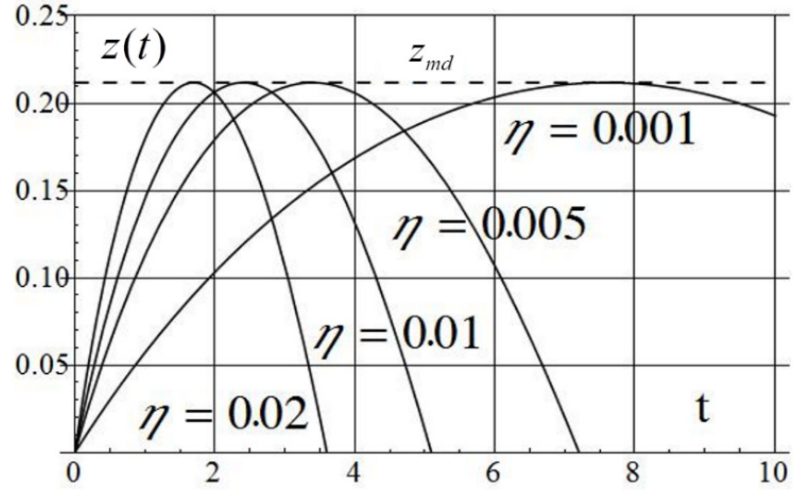
Figure 9. Submersion of a sphere from the start of deceleration until complete stop with the subse- quent ascension for an instantaneous change in buoyancy ( t 0 = 0 ) from − η to η .